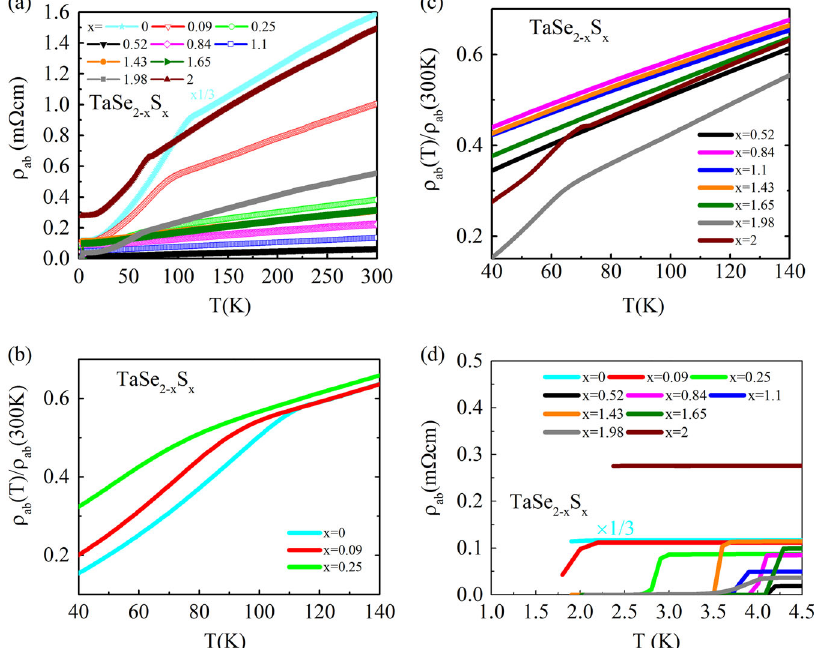
Fig. 2 Electrical resistivity of 2H-TaSe 2 − x S x (0 ≤ × ≤ 2) a Temperature dependence of the resistivity for single crystals in the absence of magnetic fi eld. b , c Temperature dependence of ρ ( T )/ ρ (300K) near CDW transitions. d ρ ( T ) curves near superconducting transitions, indicating large enhancement of